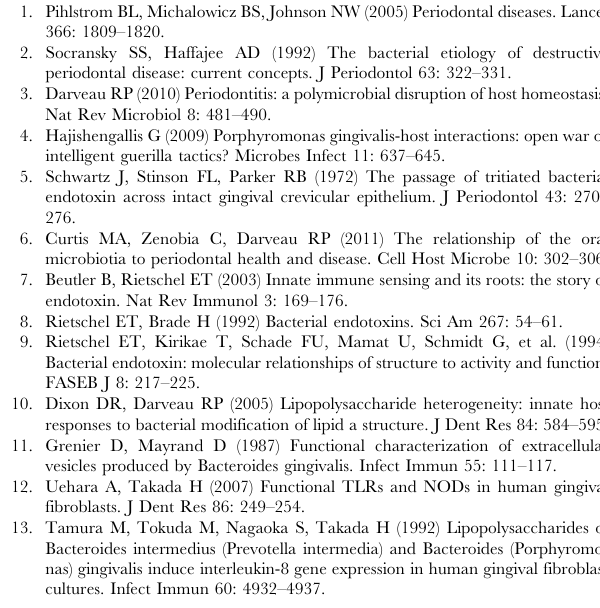
Table S1 Differential expression profile of genes associated with TLR signal transduction in HGF. The cells were treated with P.